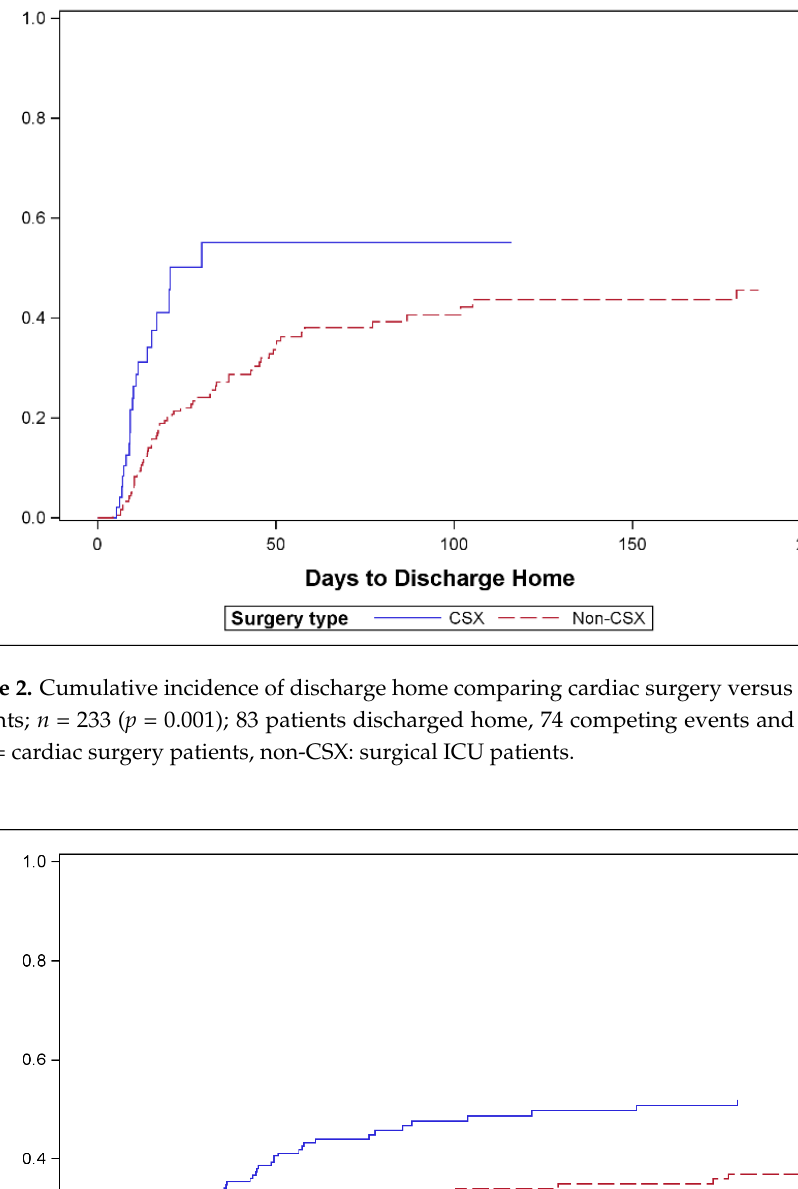
Figure 2. Cumulative incidence of discharge home comparing cardiac surgery versus surgical ICU patients; n = 233 ( p = 0.001); 83 patients discharged home, 74 competing events and 76 censored, CSX = cardiac surgery patients, non-CSX: surgical ICU patients.